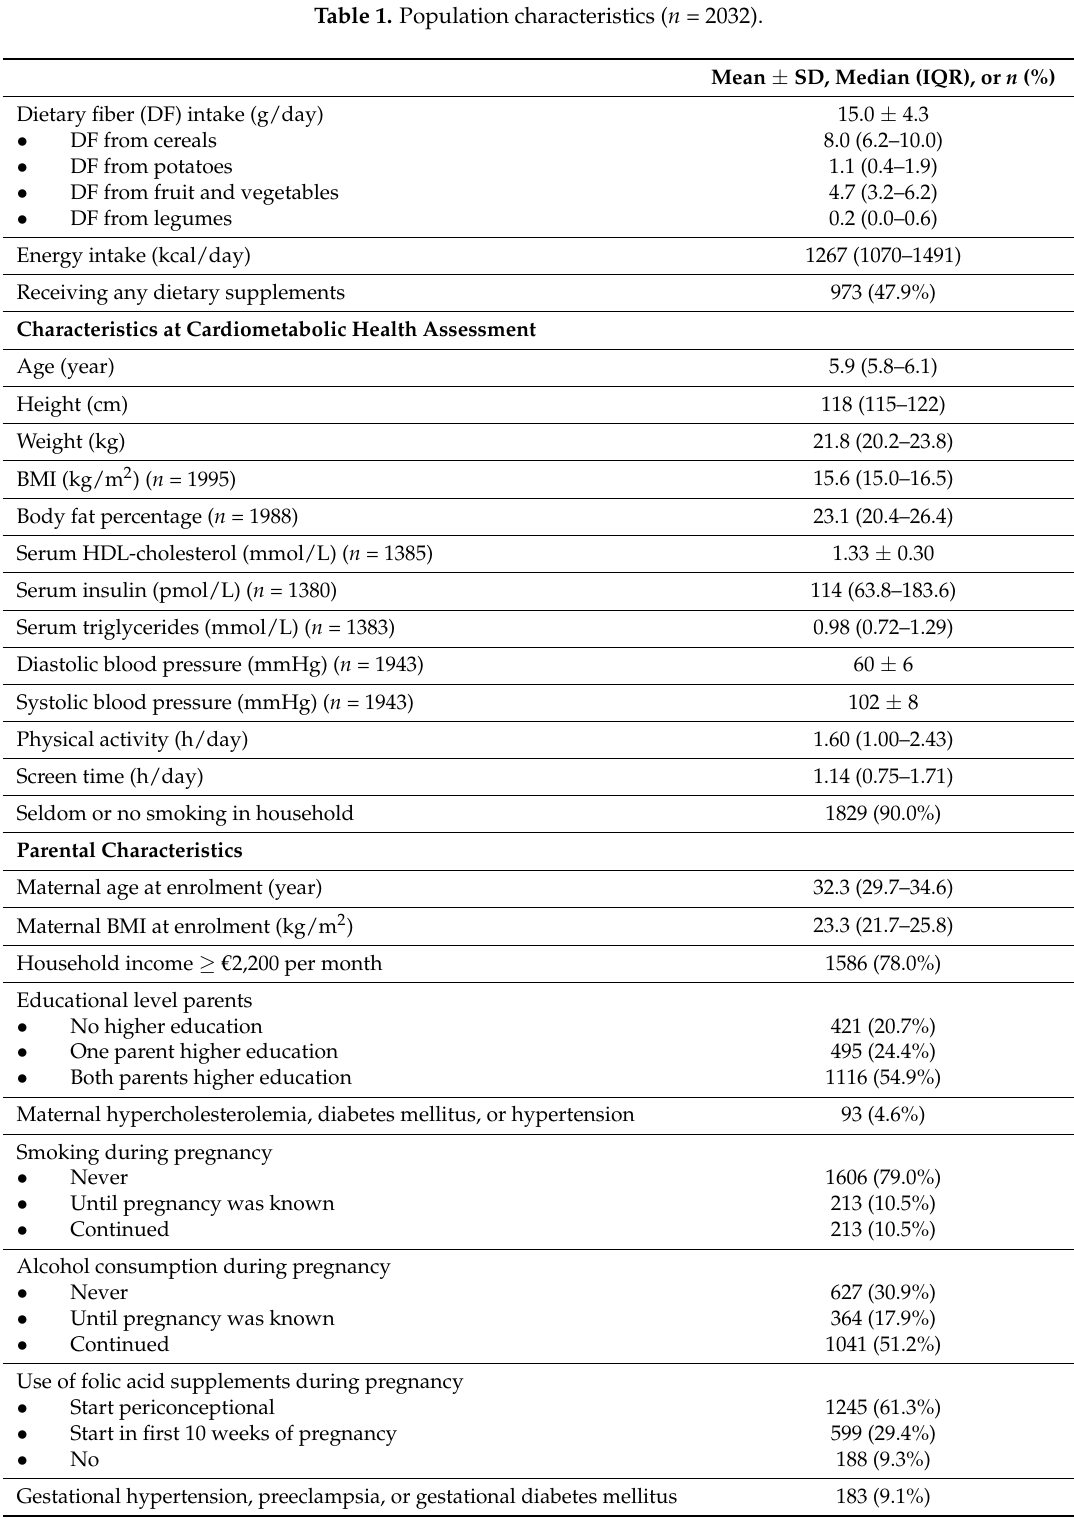
Table 1. Population characteristics ( n =